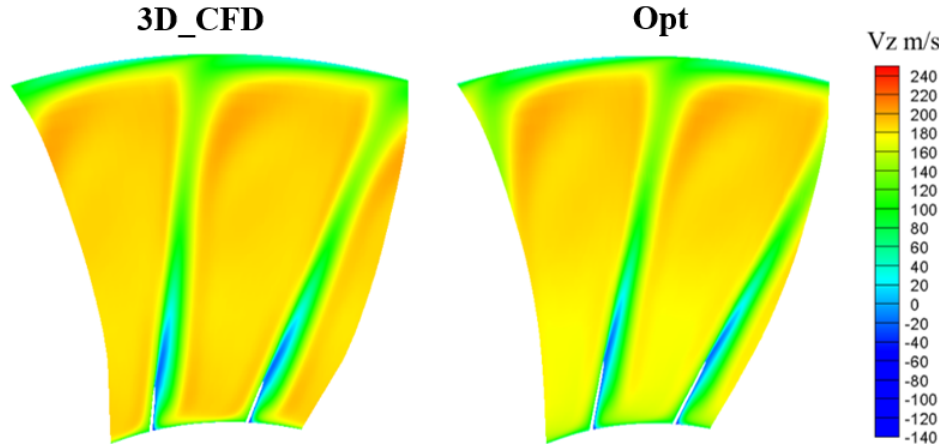
Figure 19. The distribution of the axial velocity at rotor1 outlet under the choking condition.